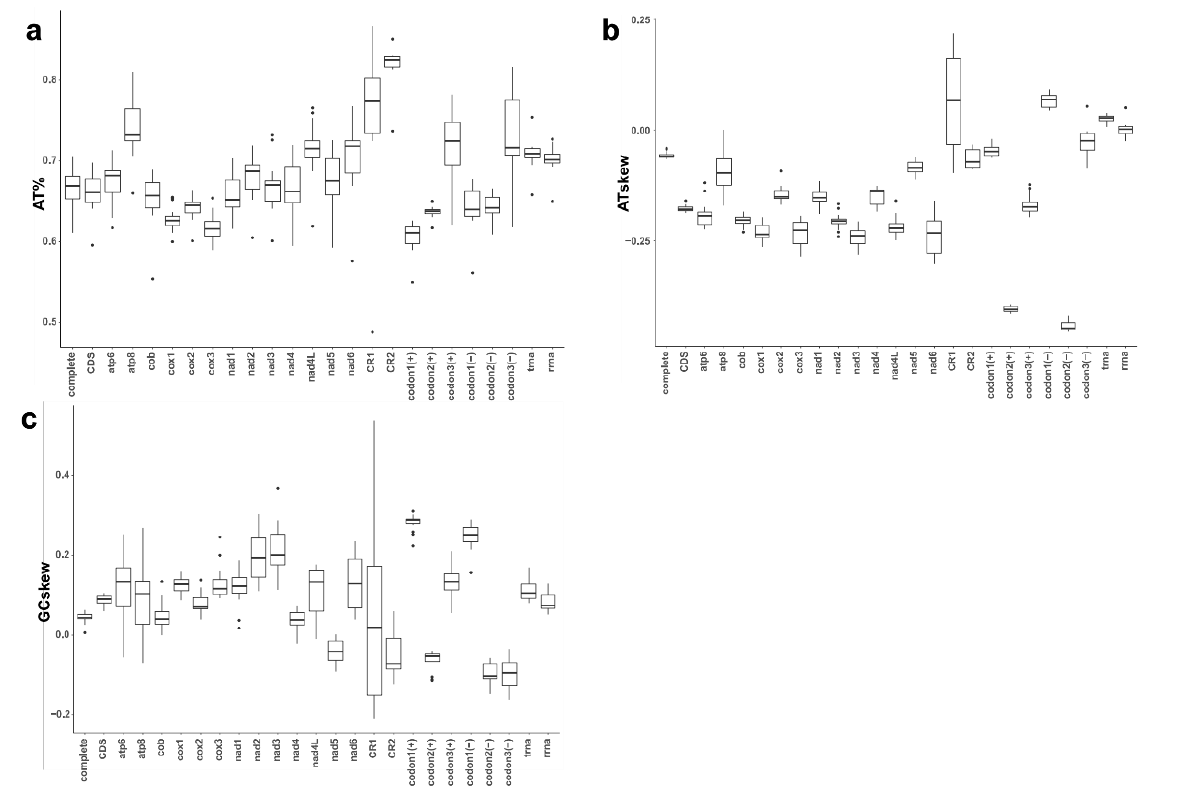
Figure 3. Mitochondrial nucleotide composition in Hyalella . Box plots showing values of nucleotide composition (A + T percentage) ( a ), AT-skew ( b ) and GC-skew ( c ) across Hyalella mitogenomes and indicated as complete, genes, codons, partitions and strands.